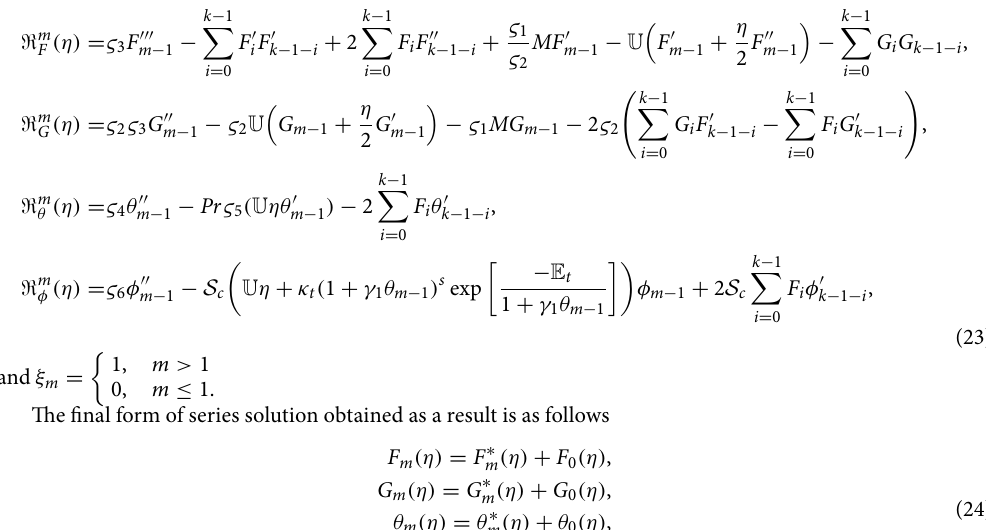
Figure 2. Combined h-curves.